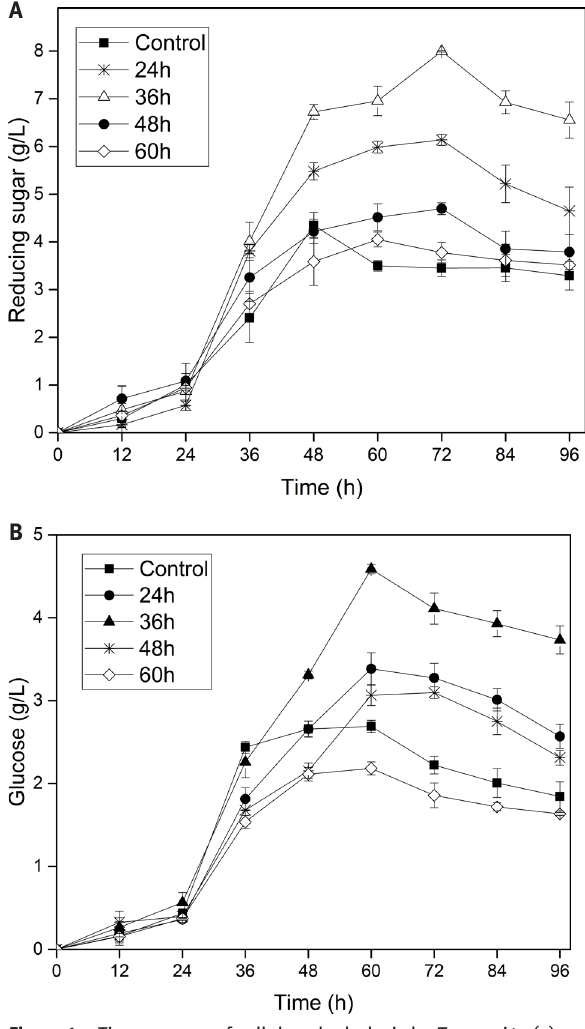
Figure 1: Time courses of cellulose hydrolysis by T. reesei to (a) reducing sugar production and (b) glucose production at different temperature rise times (24 to 60 h). The temperature rise time refers to the period of cultivation at 30°C prior to increasing to 50°C. For example, the 24 h temperature rise time means that T. reesei was first grown at 30°C and the temperature was risen to 50°C after 24 h. Control means constant temperature operation at 30°C (no temperature change).